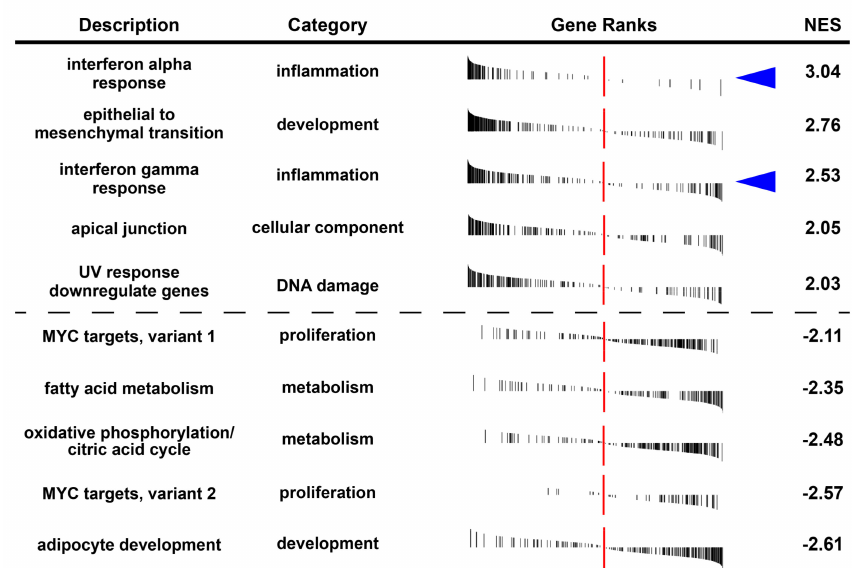
Figure 6. Visualization of the five most positively (NES > 0) or negatively (NES < 0) TNF α -dependent hallmark gene sets in ADSCs, when compared to L-WAT. Blue arrowheads indicate the di ff erence of interferon alpha and gamma response of ADSCs and L-WAT upon TNF α treatment. NES: normalized enrichment score. Adjusted p -value <